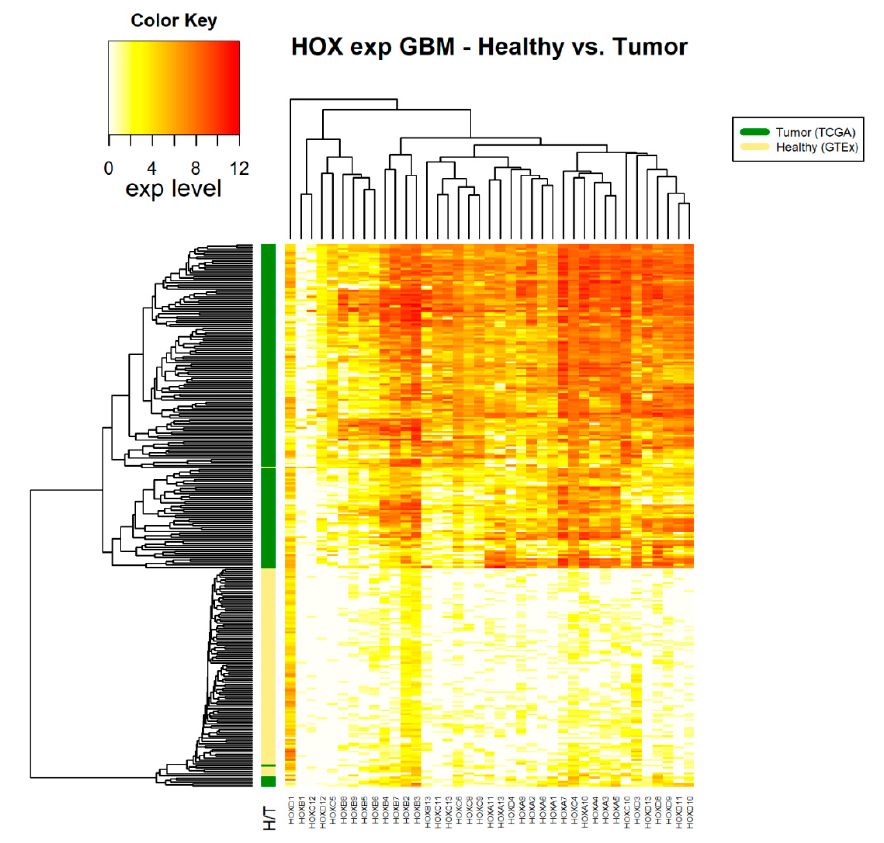
Figure 2. HOX gene expression in tumor and healthy breast tissue samples. The source of expression data of healthy and tumor samples is GTEx and TCGA, respectively.